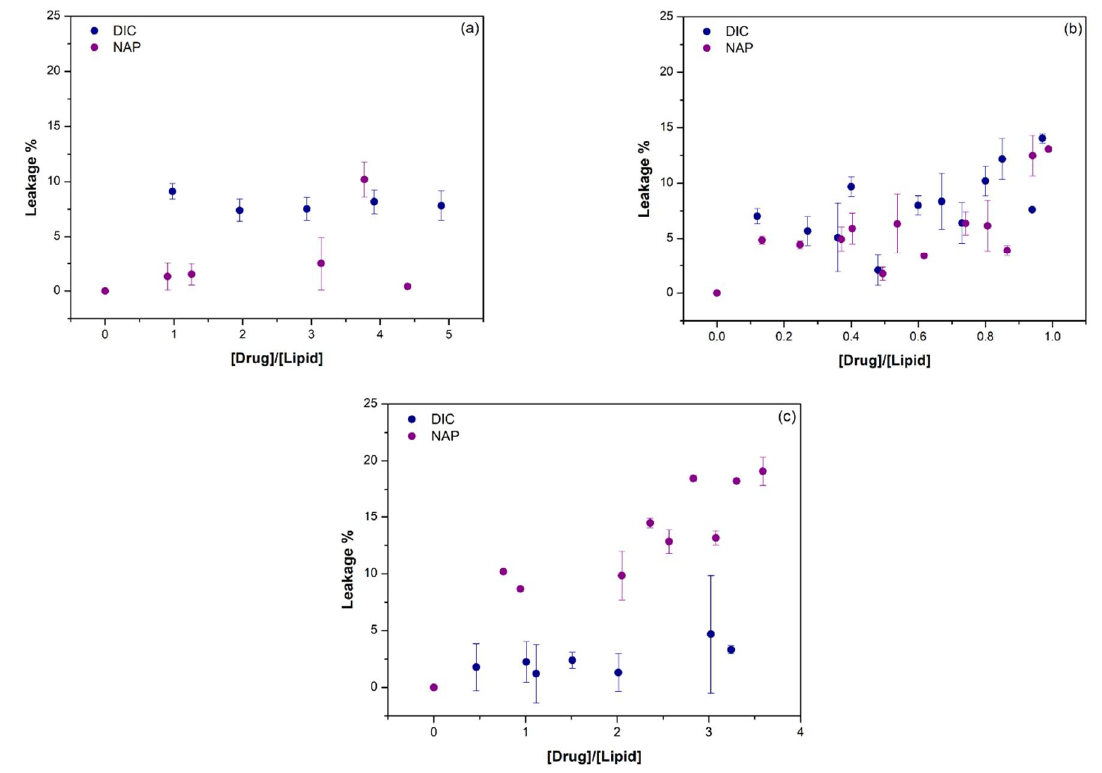
Figure 3. The effect of drug:lipid molar ratio on the PTS leakage from ( a ) POPC:CHOL (80:20), ( b ) POPC:TMCL (85:15), or ( c ) POPC:PI (85:15) LUVs at 37 °C and pH 7.4. DIC (blue circles) and NAP (purple circles) induced effects are presented as mean ± standard deviation of at least two replicates.